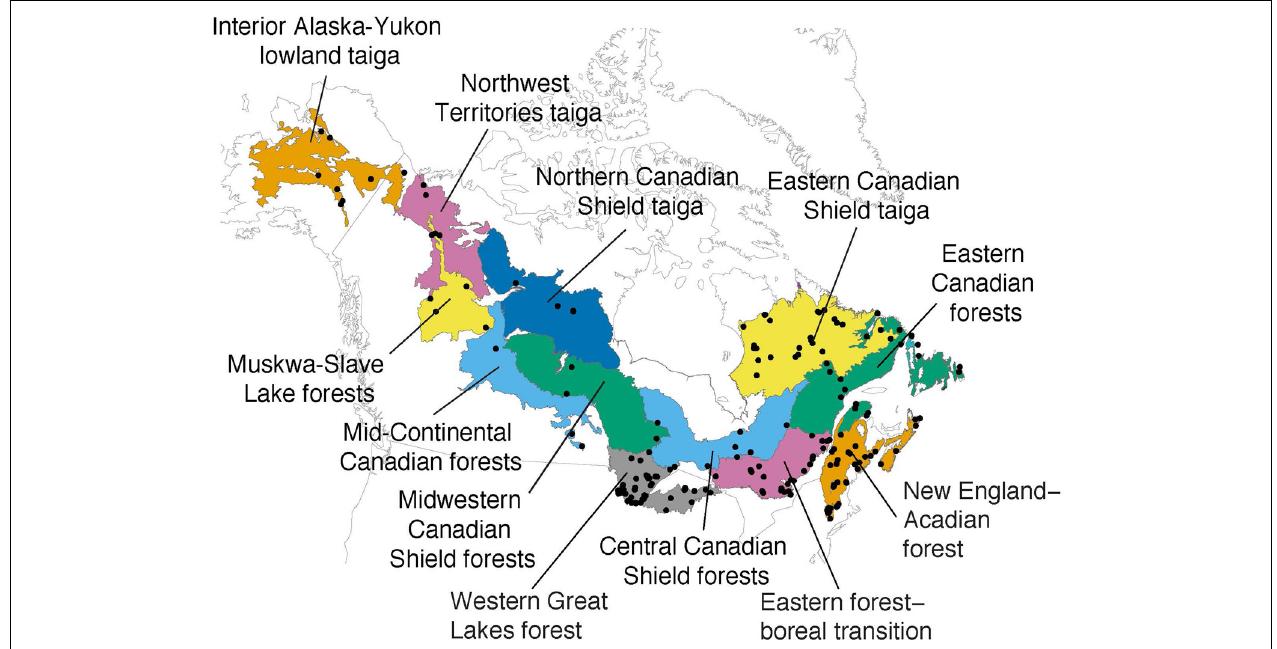
FIGURE 1 | Location map of the selected fossil pollen sites (black dots) and the ecoregion units (colored areas) from the boreal forest taiga biome (adapted from Girardin et al., 2009).